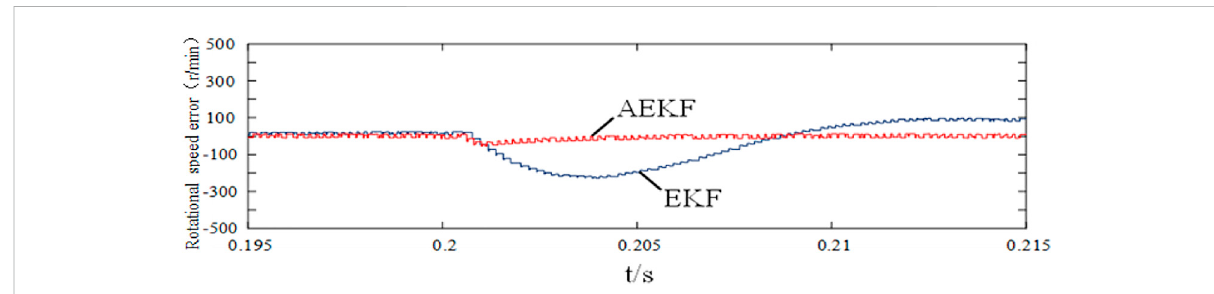
FIGURE 2 Speed error under sudden load change.